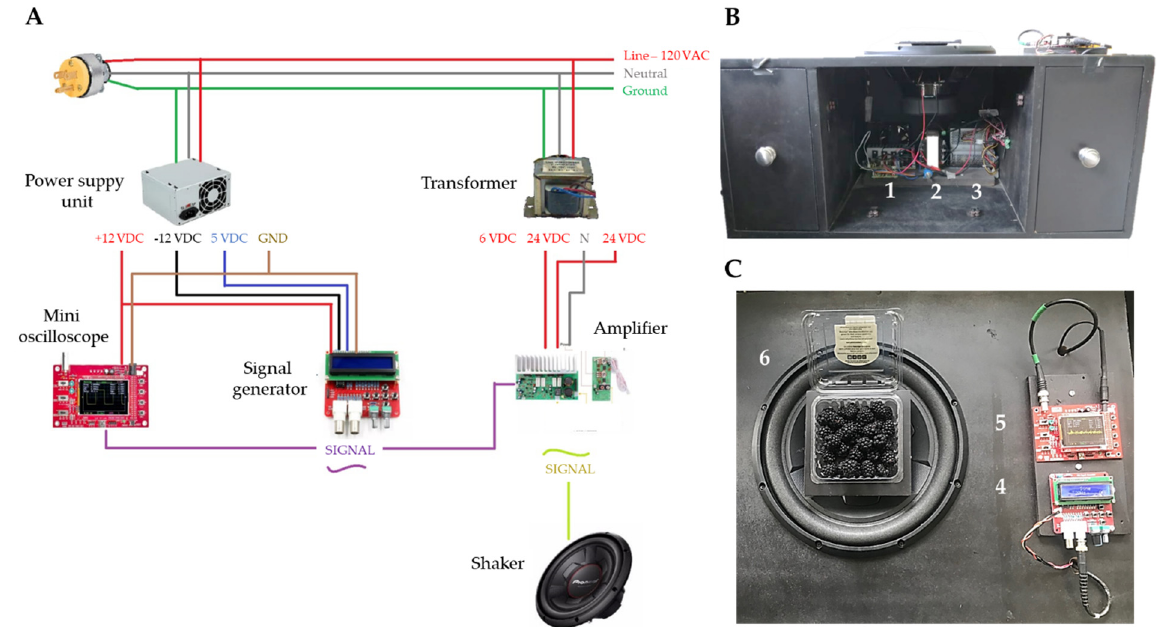
Figure 1. Elements of portable vibration system. ( A ) System operations diagram with its main components. Front view ( B ) and upper view ( C ) of the system. 1 : amplifier; 2 : transformer; 3 : power supply unit; 4 : signal generator; 5 : mini oscilloscope; and 6 : subwoofer (shaker). VDC: volts of direct current; VAC: volts of alternating current; GND: ground; N: neutral.